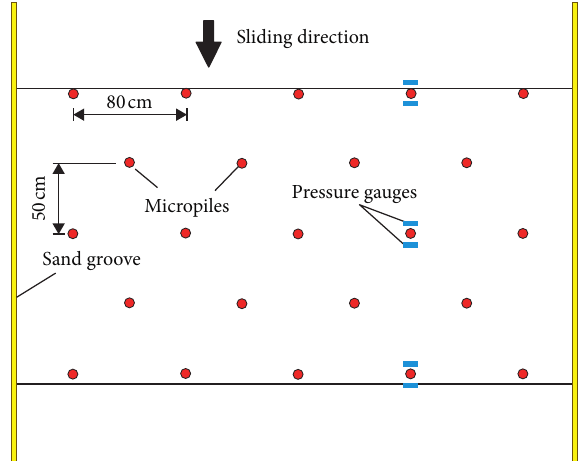
Figure 6: Layout of micropiles and pressure gauges (unit: cm).